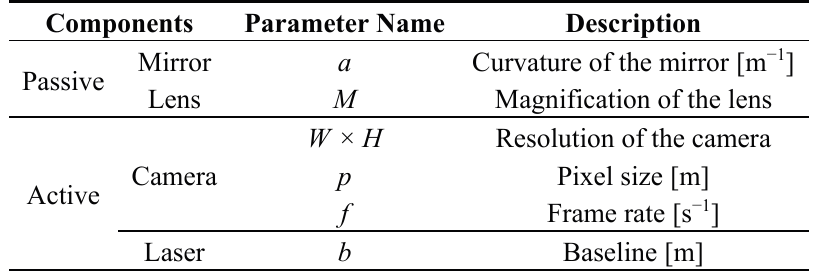
Table 2. List of geometrical and physical parameters involved in the range